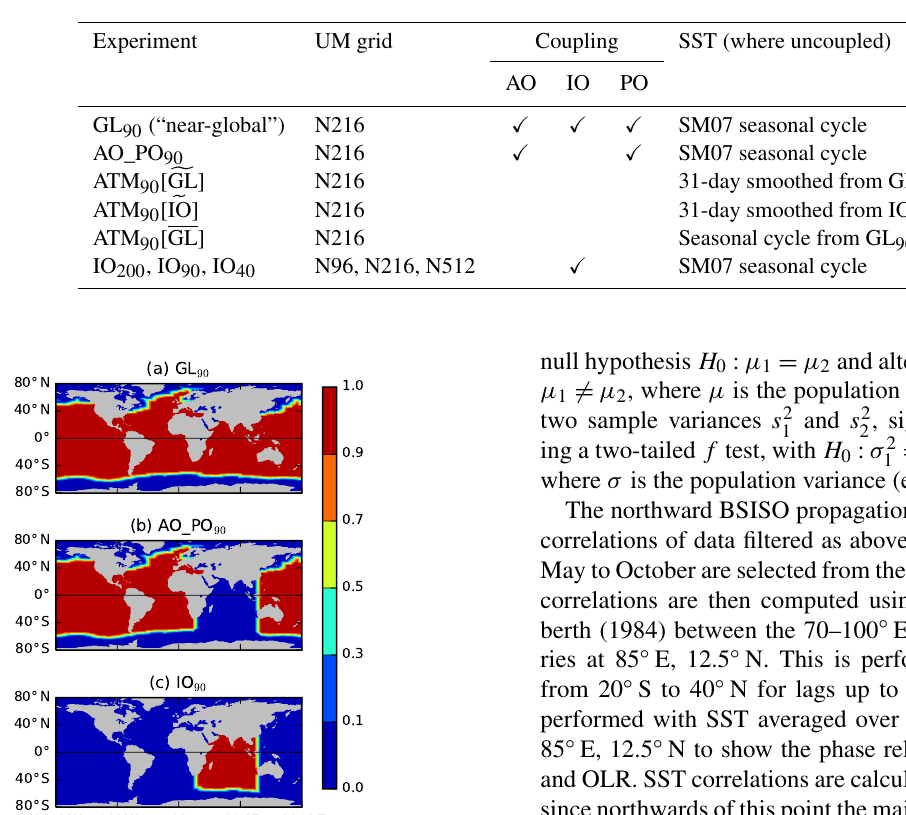
Table 1. List of experiments performed. Subscripts indicate the approximate grid spacing in kilometres at the Equator. Ticks indicate the ocean basins (Atlantic Ocean, Indian Ocean, and Pacific Ocean) in which the MetUM was coupled to MC-KPP. (Maps of the coupling regions are shown in Fig. 1.) The final column indicates the SST prescribed in regions where the atmosphere is not coupled to the mixed layer ocean.